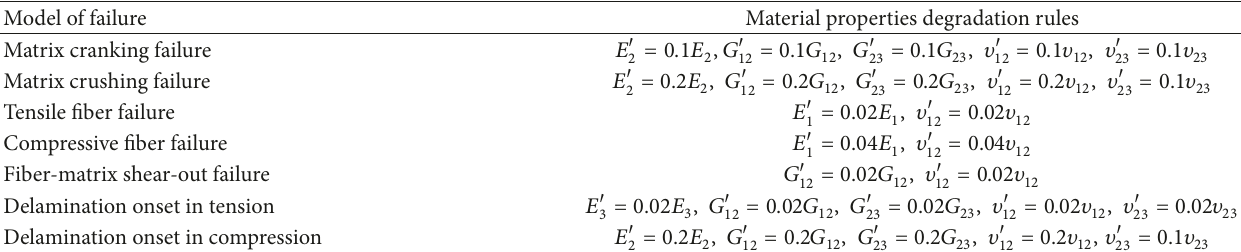
Table 4: Material property degradation for each failure criterion.